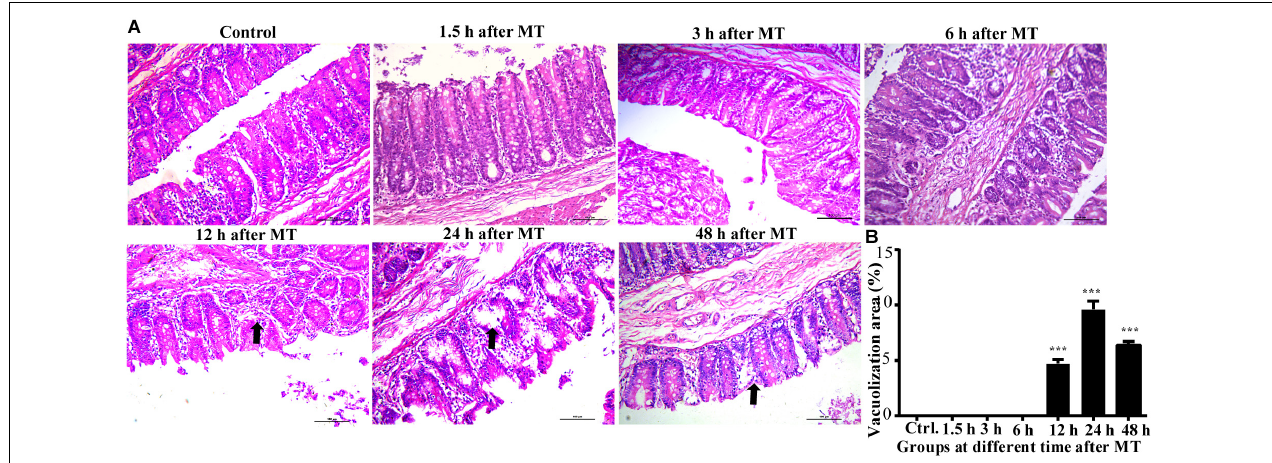
FIGURE 3 | Changes in the cecal mucosa of the SD rats at different time points after MT (200 × ). (A) HE stainingof cecalmucosa in SD ratsat different time points after MT. The black arrow shows obvious vacuolated changes in 12, 24, and 48 h after MT. No obvious changes were observed in the control, 1.5, 3, and 6 h.